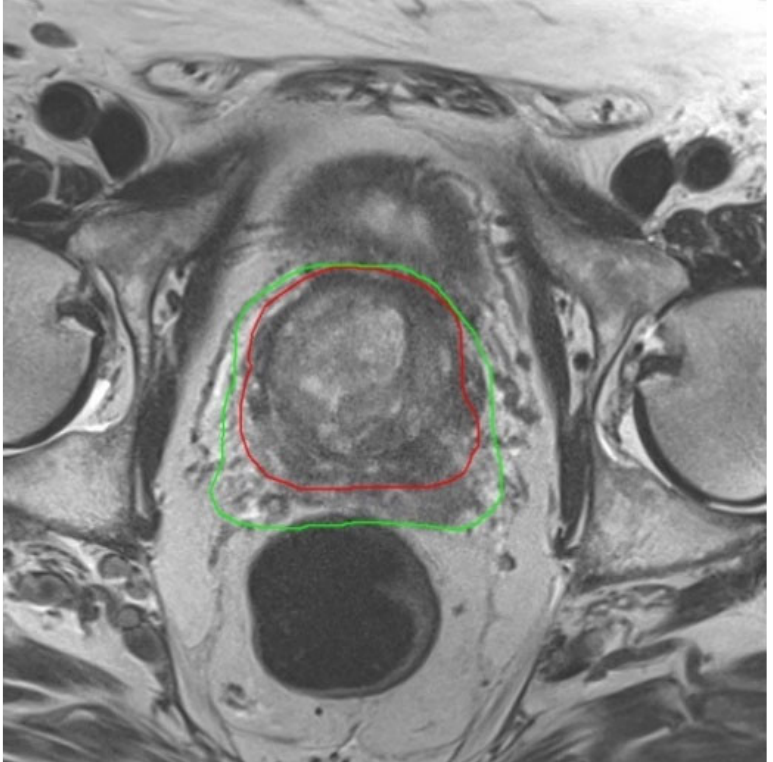
Figure 2. Image of MRI 1 acquired before beginning of ADT with the 60 Gy Isodose-line (green) in treatment plan. The red line is the 60 Gy Isodose-line from treatment plan based on MRI 2 after shrinkage of the prostate by ADT. The dose burden of the rectum is clearly lowered by using a new MRI after ADT.